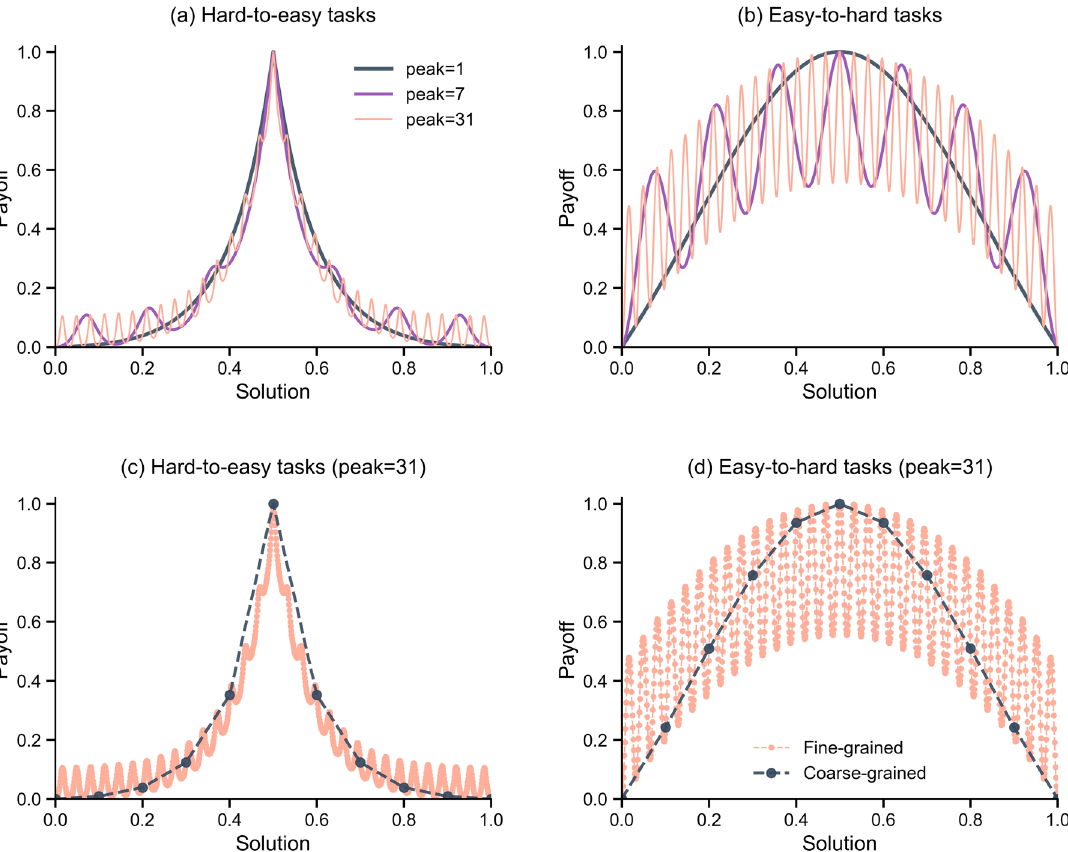
Fig. 1 The hard-to-easy and easy-to-hard tasks with different complexity and granularity. a The hard-to-easy tasks with 1, 7, and 31 peaks. b The easy- to-hard tasks with 1, 7, and 31 peaks. c Fine-grained and coarse-grained hard-to-easy tasks with 31 peaks. d Fine-grained and coarse-grained easy-to-hard tasks with 31 peaks. Fine-grained: ω = 3. Coarse-grained: ω =